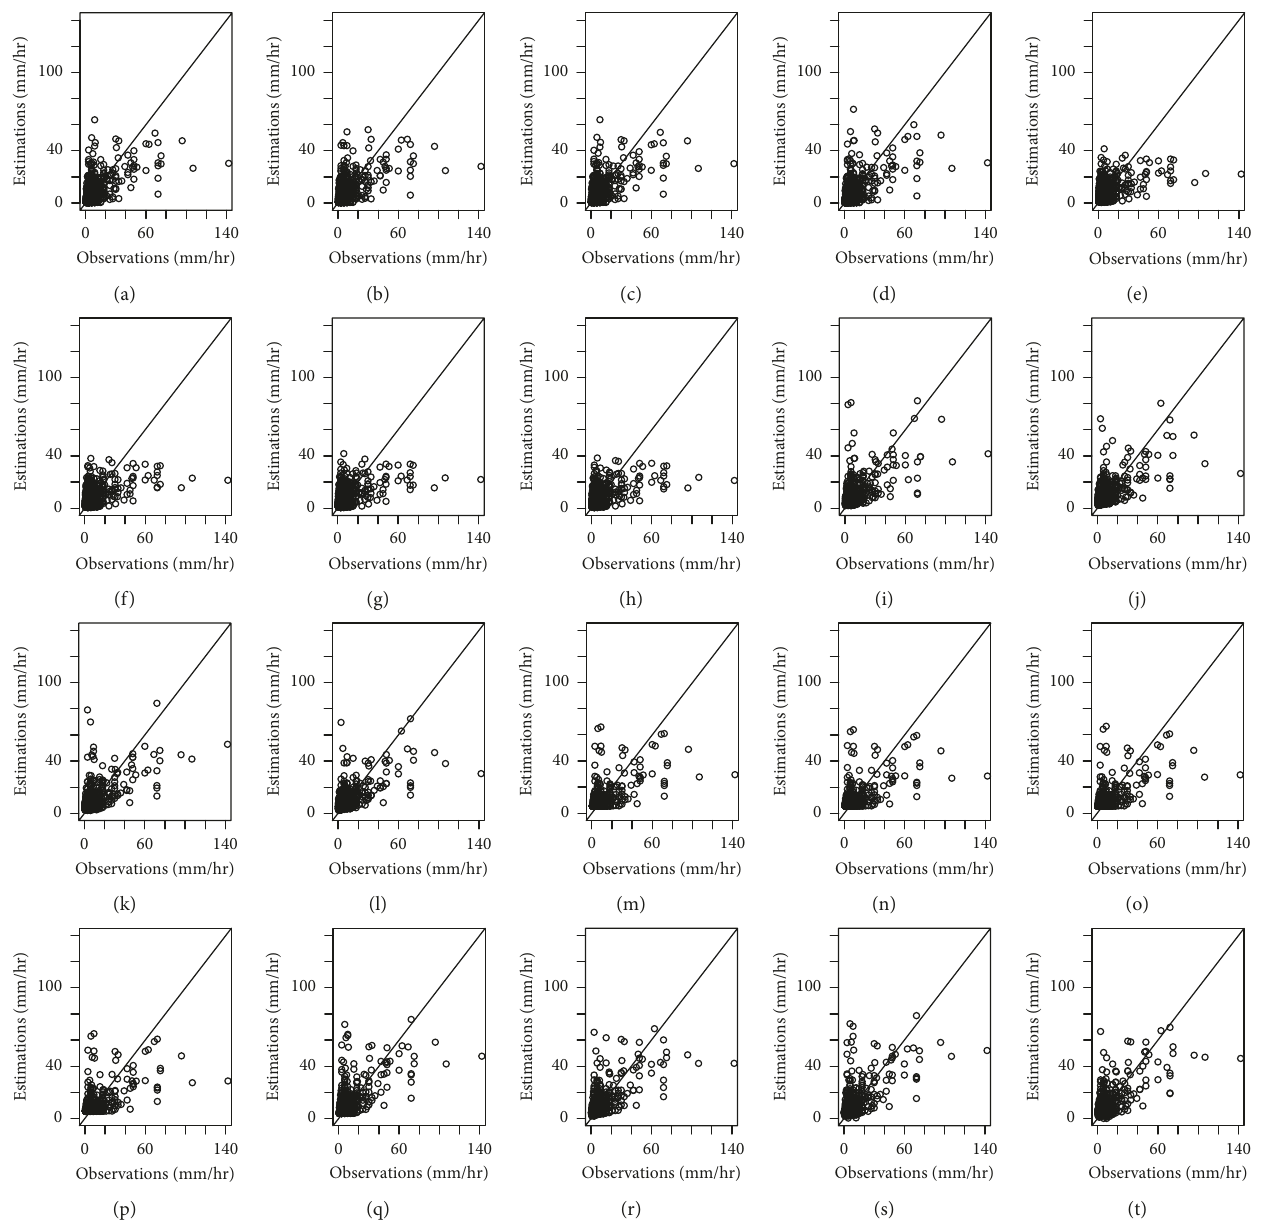
Figure 4: Plots of rainfall rate estimation versus observations for the models tested for all precipitation events studied. (a) ZR1-L1 (RMSE: 8.75, R : 0.58). (b) ZR2-L1 (RMSE: 8.87, R : 0.56). (c) ZR3-L1 (RMSE: 8.74, R : 0.58). (d) ZR5-L1 (RMSE: 8.86, R : 0.58). (e) ZR1-L0 (RMSE: 9.33, R : 0.47). (f) ZR2-L0 (RMSE: 9.36, R : 0.46). (g) ZR3-L0 (RMSE: 9.35, R : 0.47). (h) ZR5-L0 (RMSE: 9.37, R : 0.46). (i) RF1 (RMSE: 8.56, R : 0.6). (j) RF2 (RMSE: 8.26, R : 0.63). (k) RF3 (RMSE: 8.36, R : 0.62). (l) RF5 (RMSE: 8.18, R : 0.63). (m) GBM1 (RMSE: 8.38, R : 0.61). (n) GBM2 (RMSE: 8.43, R : 0.61). (o) GBM3 (RMSE: 8.38, R : 0.24). (p) GBM5 (RMSE: 8.43, R : 0.6). (q) ELM1 (RMSE: 8.37, R : 0.64). (r) ELM2 (RMSE: 7.99, R : 0.66). (s) ELM3 (RMSE: 8.33, R : 0.64). (t) ELM5 (RMSE: 7.91, R :